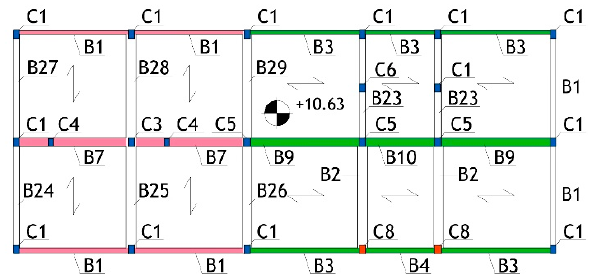
Figure 15. Localization of the interventions—second storey.